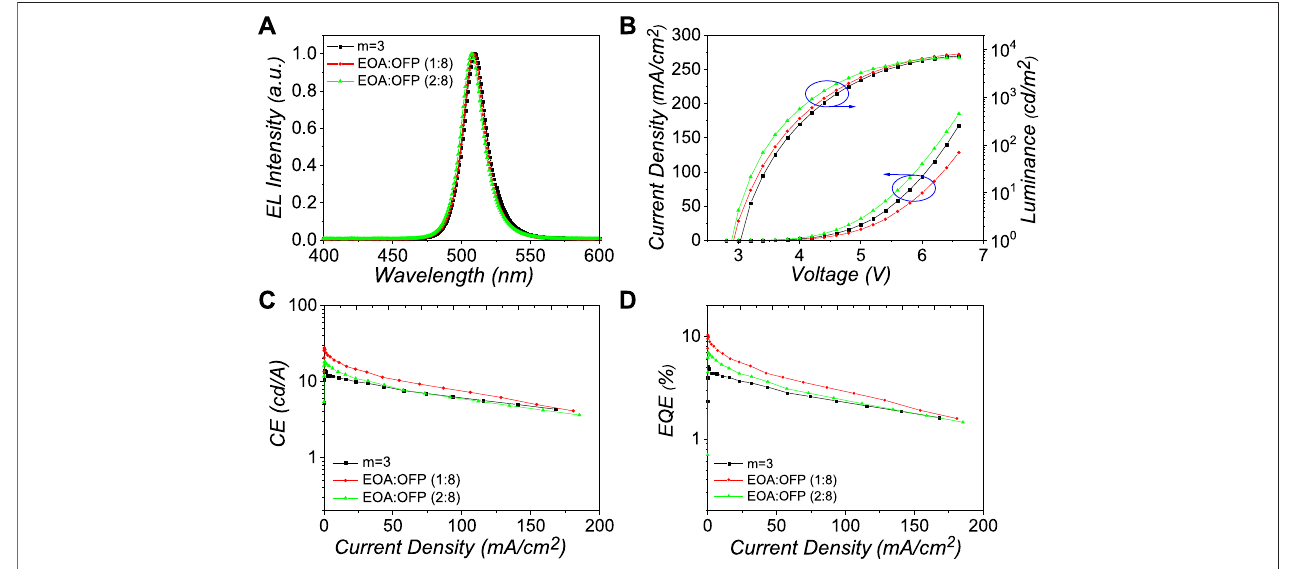
TABLE 1 | Summary of the device performance with different interlayers as the light-emitting layers. Light-emitting layers